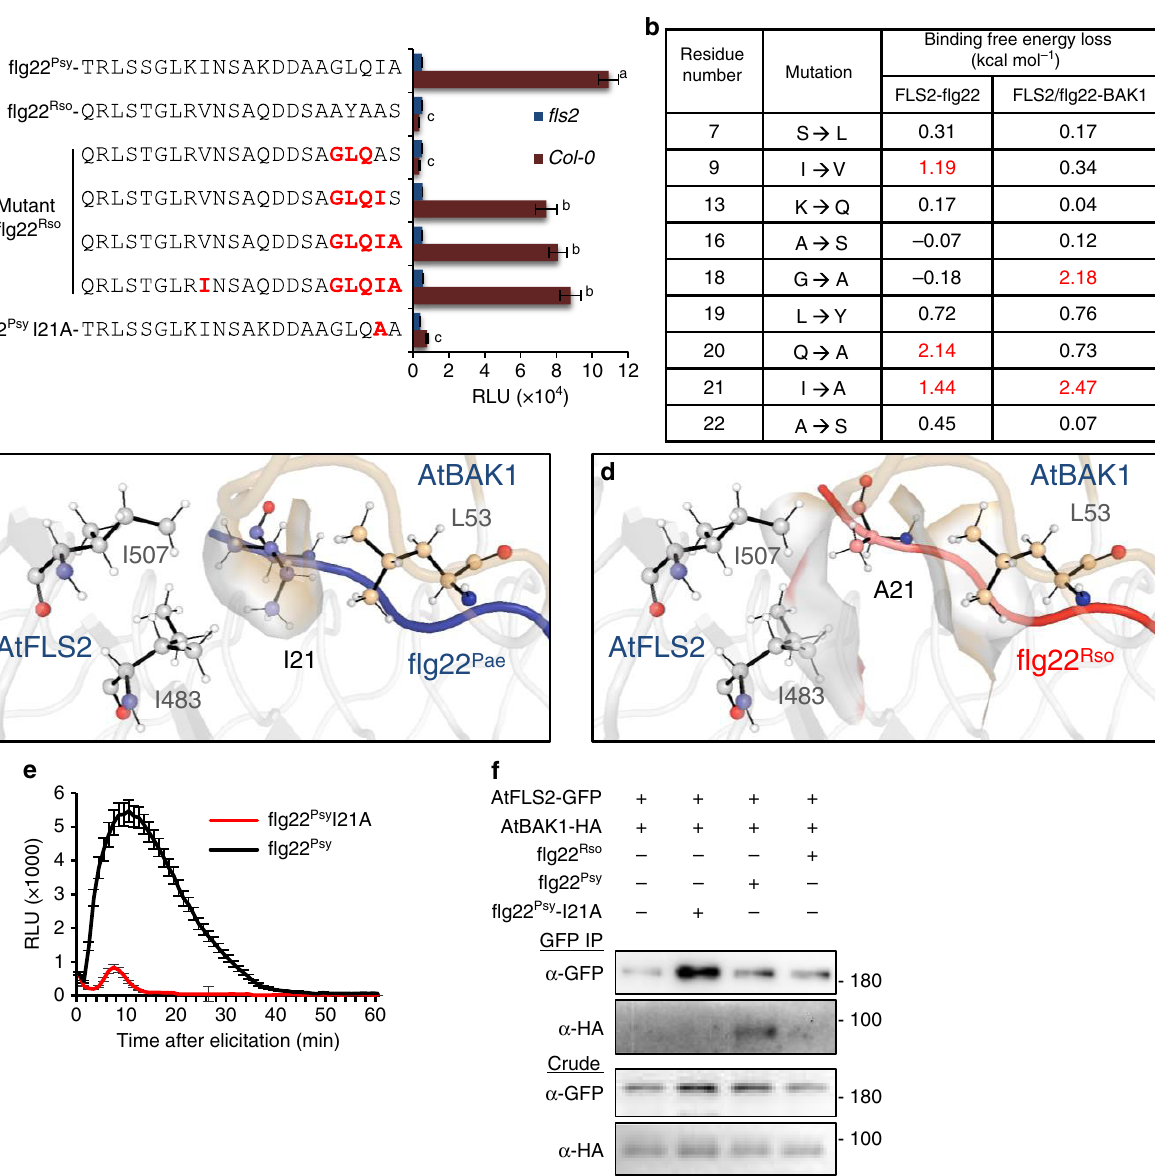
Fig. 1 Analysis of polymorphisms in R. solanacearum fl g22. a ROS burst triggered by the indicated peptides (100 nM) in leaf discs from Arabidopsis Col-0 wild-type or an fl s2 mutant, measured in a luminol-based assay, and represented as accumulated relative luminescence units (RLU) (mean ± SEM, n = 16). The measurement was performed from 1 to 40 min after treatment. The elicitor peptide fl g22 Psy was used as control. Different letters indicate signi fi cant differences using a one-way ANOVA and Tukey correction for multiple comparisons ( p < 0.05). This experiment was repeated 3 times with similar results. b Effect of single amino acid changes on binding free energy in a two-step triplex formation (FLS2- fl g22 and FLS2/ fl g22-BAK1), measured in kcal mol − 1